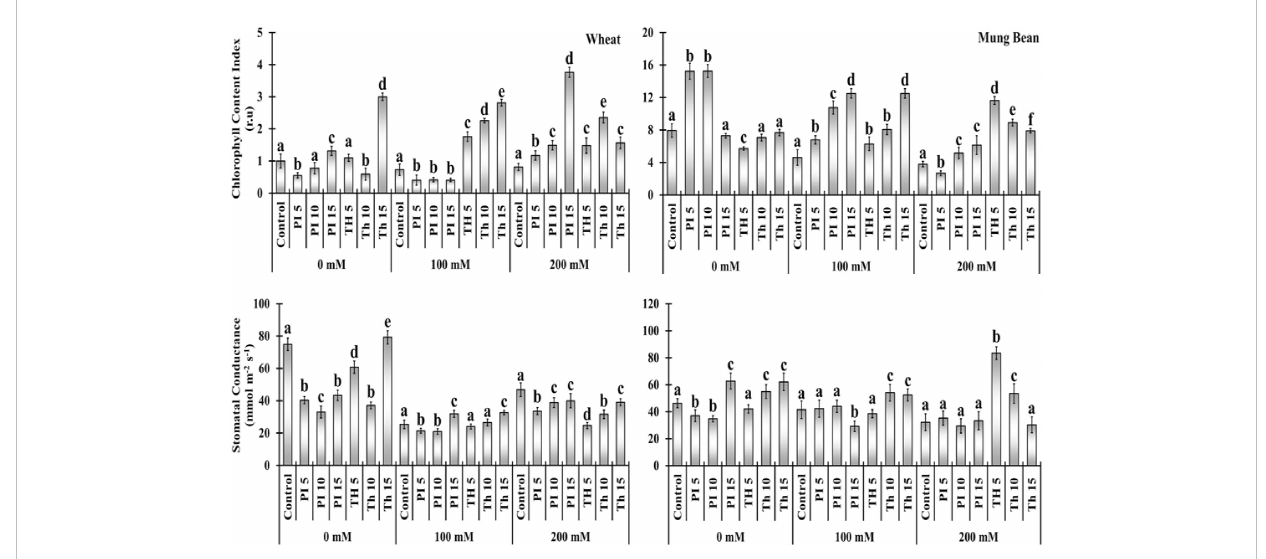
FIGURE 3 Effects of bio-priming on chlorophyll content index (CCI) and stomatal conductance (gs) of wheat and mung bean plants grown under saline environment. The symbols on the horizontal axis represents: Control: Seeds without priming, Pl = Seed priming with Paecilomyces lilacinus , Th = Seed priming with Trichoderma hamatum 5, 10, 15 = duration of bio-priming in minute, 0, 100 &200 mM NaCl concentration. On bars, vertical lines represent ± Mean Standard Error (S.E) and similar alphabets represents non-signi fi cant difference between the means of treatment at p<0.05